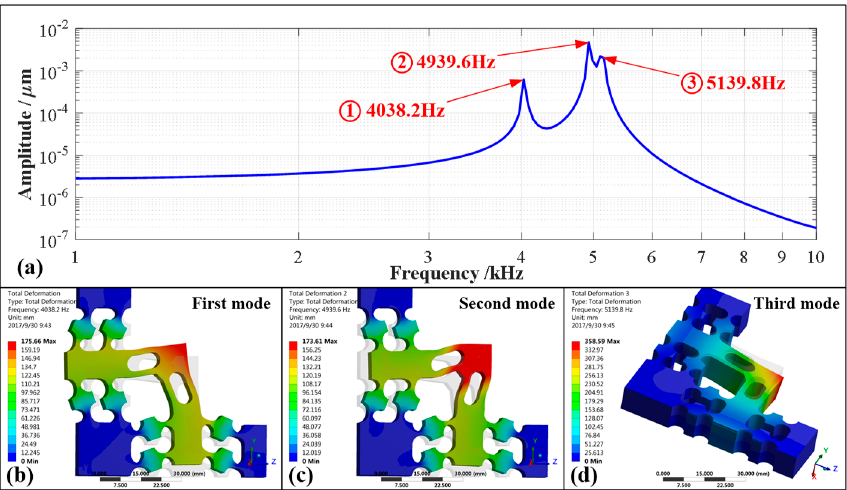
Figure 8. Dynamic study of the 2-DOF PDCM based on the finite element analysis (FEA) method. ( a ) Harmonic analysis; ( b ) First mode (4038.2 Hz); ( c ) Second mode (4939.6 Hz); ( d ) Third mode (5139.8 Hz).